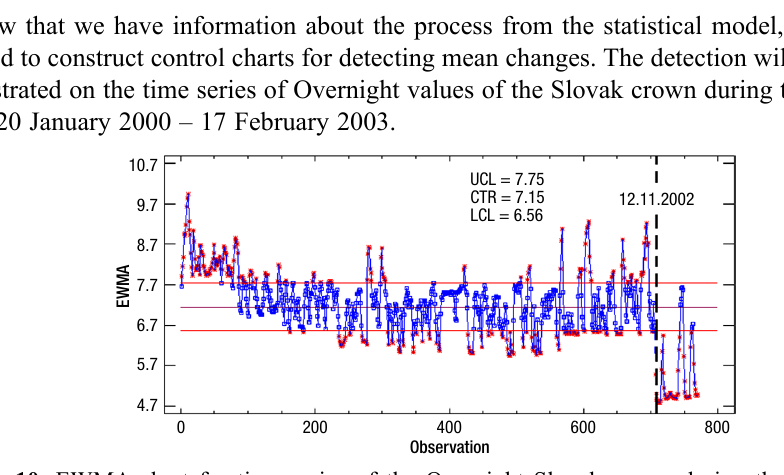
Fig. 10. EWMA chart for time series of the Overnight Slovak crown during the period of